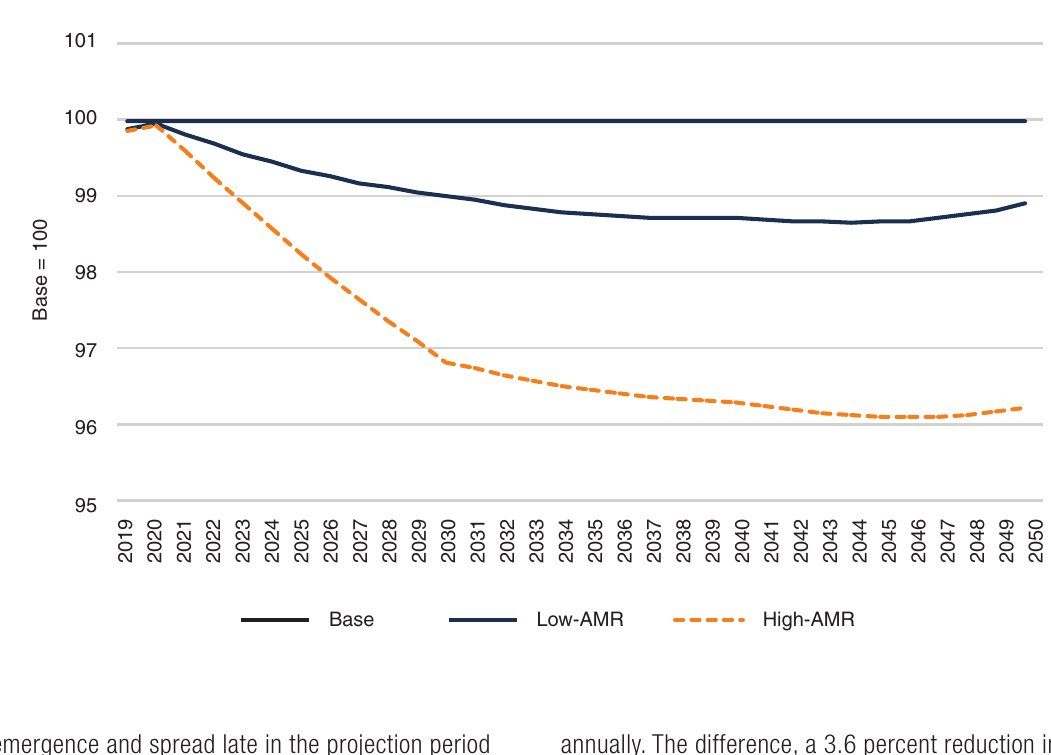
FIGURE 2. Substantial and Protracted Shortfalls in Global Economic